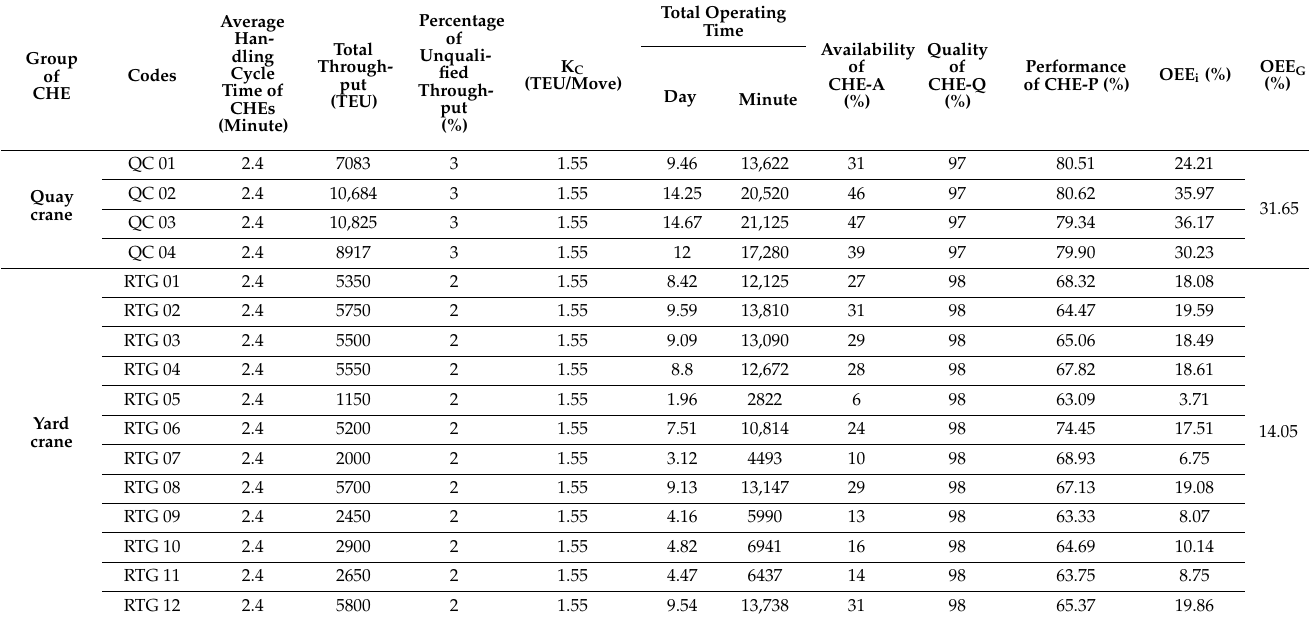
Table 7. Calculation of values of A, P, Q, OEEi, and OEE G of Nam Dinh Vu terminal in December